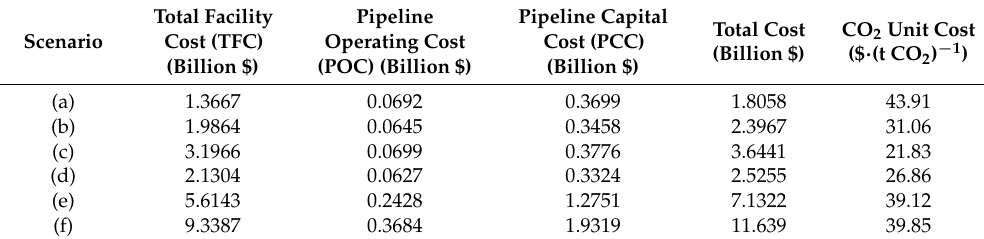
Table 6. The results by cost of each